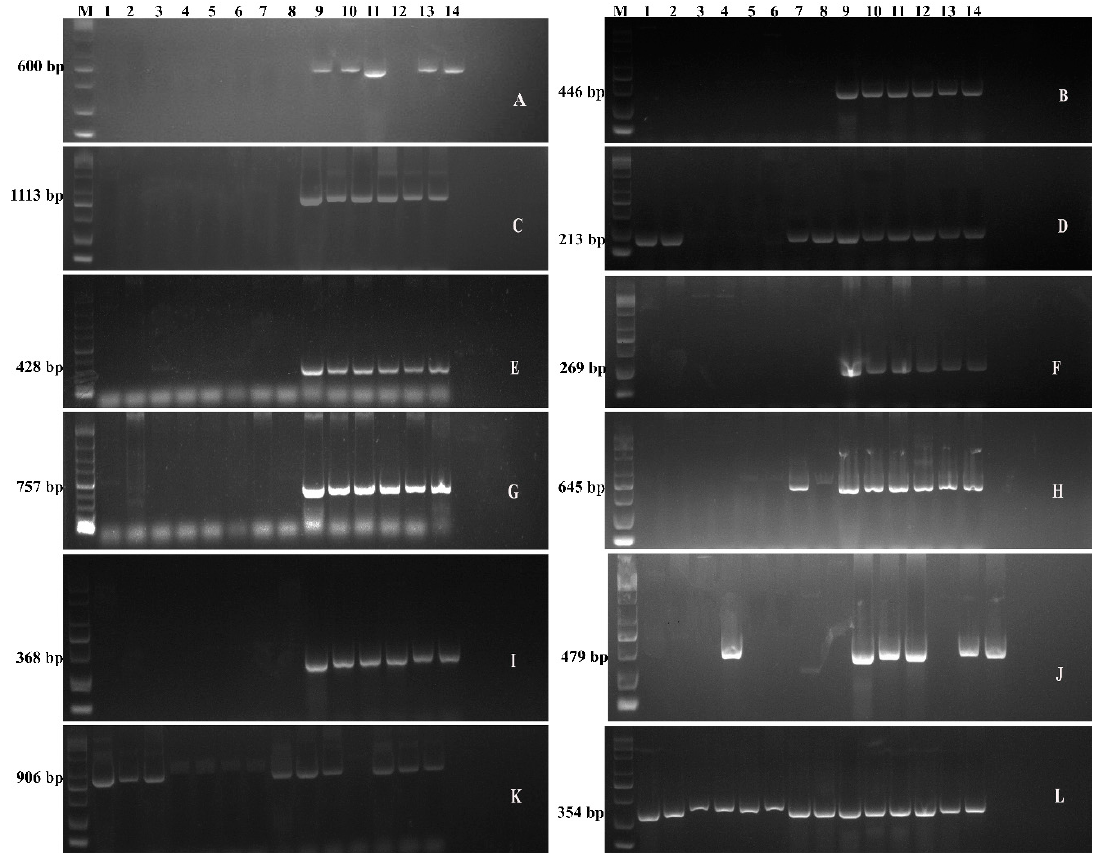
Figure 2. The Gel electrophoresis showing the detection of genes related to cold-tolerance in di ff erent Bacillus i.e., 1-GBSW11, 2-BS168, 3-LLCG23, 4-GBAC46, 5-DJFZ40, 6-LLTC96, 7-GBSW2, 8-FZB42, 9-CJCL2, 10-NMSW12, 11-RJGP41, 12-GBSW19, 13- LNXM10, 14-NMSL88 Whereas The genes detected are: desR ( A ), SodA ( B ), desK ( C ), trxA ( D ), ResD ( E ), ohrR ( F ), DegS ( G ), ComA ( H ), dpsU20 ( I ), OpuAC ( J ), KatA ( K ), perR ( L ).